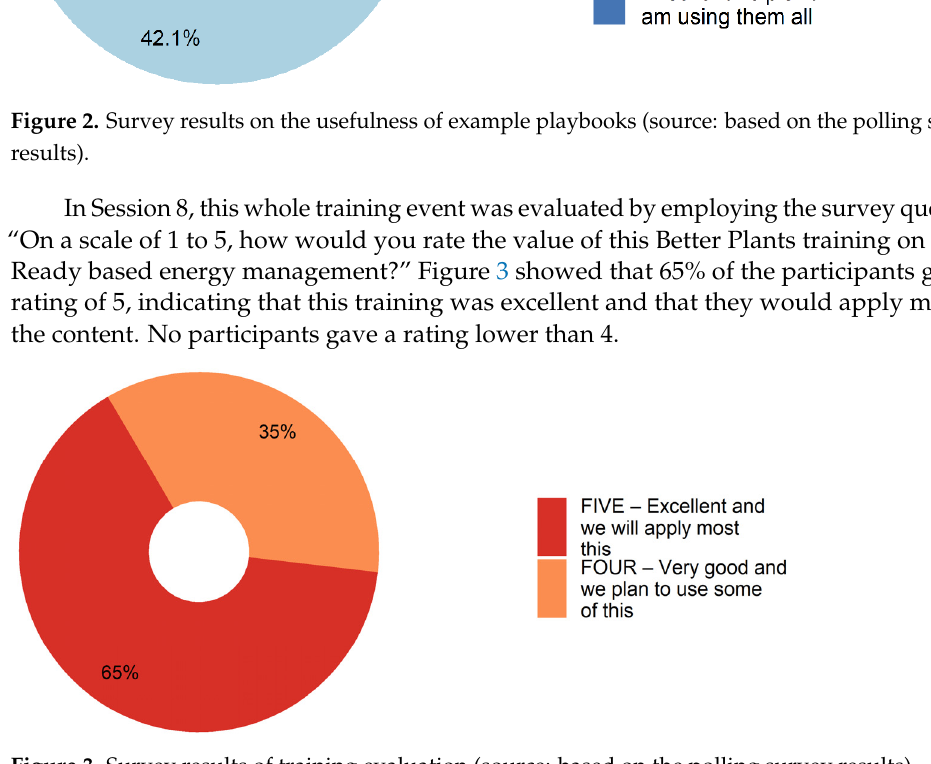
Figure 3. Survey results of training evaluation (source: based on the polling survey results).